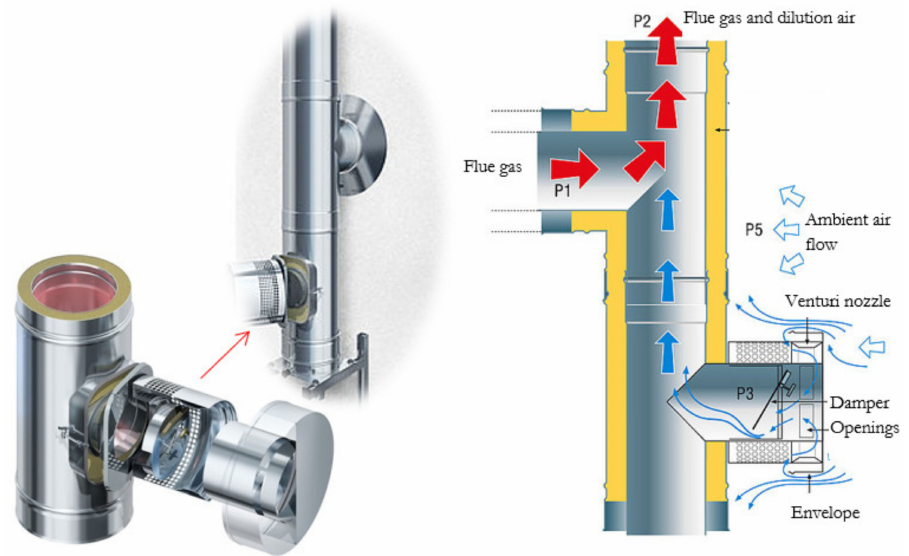
Figure 5. External draught control device ZUK 130 DW (left) and its functionality (right) from the company Kutzner + Weber (K+W) [45] (translated into English). Reprint with permission from Zugbegrenzer ZUK 130 DW; Copyright 2015, Kutzner + Weber